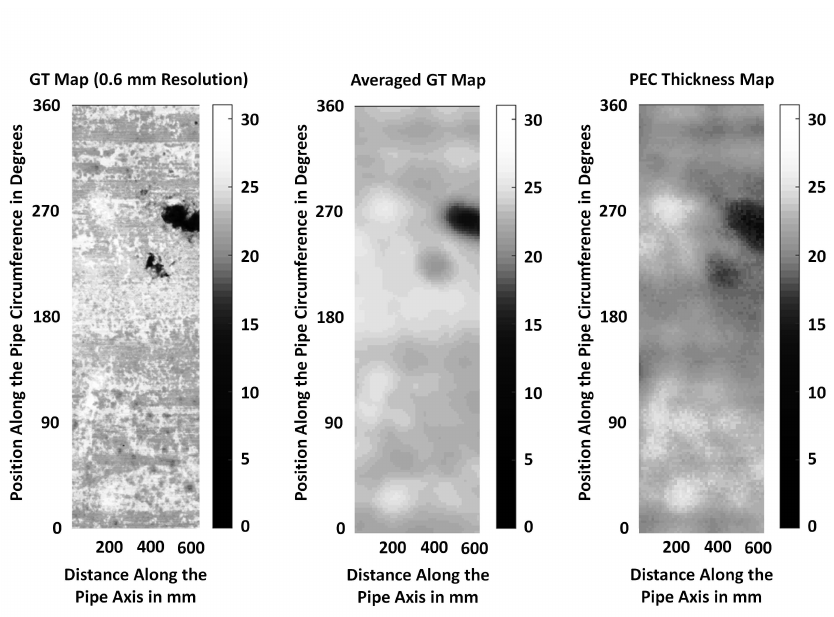
Figure 26. Thickness maps of a grey cast iron